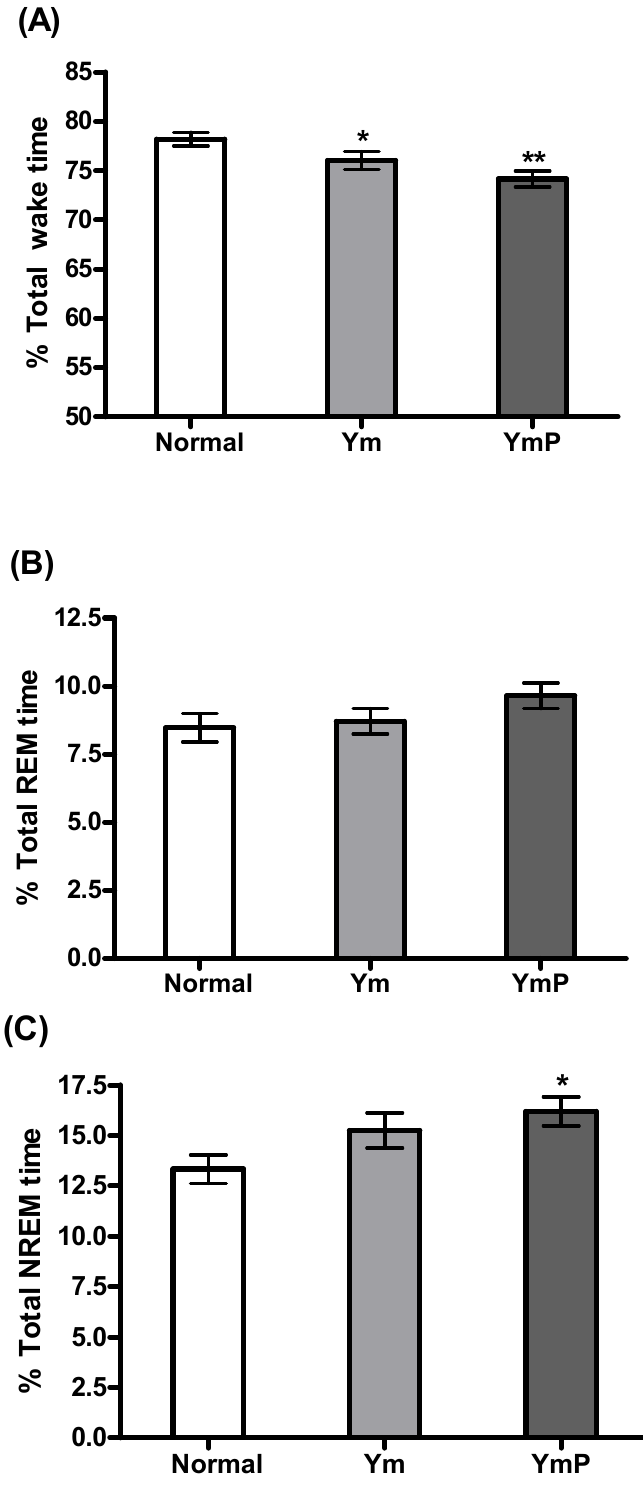
Figure 3. The effect of YmP on sleep architecture in the rat. Changes in the percentage of wake ( A ), REM sleep ( B ), and NREM sleep ( C ) during the dark phase are shown in the Ym and YmP-treated groups. The data represent the mean ± SEM of percent time spent in the sleep–wake state. * p < 0.05 vs. Normal (saline-treated group), ** p < 0.001 vs. Normal (saline-treated group); one-way ANOVA followed by Tukey HSD. Yukmijihwang-tang (Ym); modified Yukmijihwang-tang (YmP); rapid eye movement (REM); non-rapid eye movement (NREM).